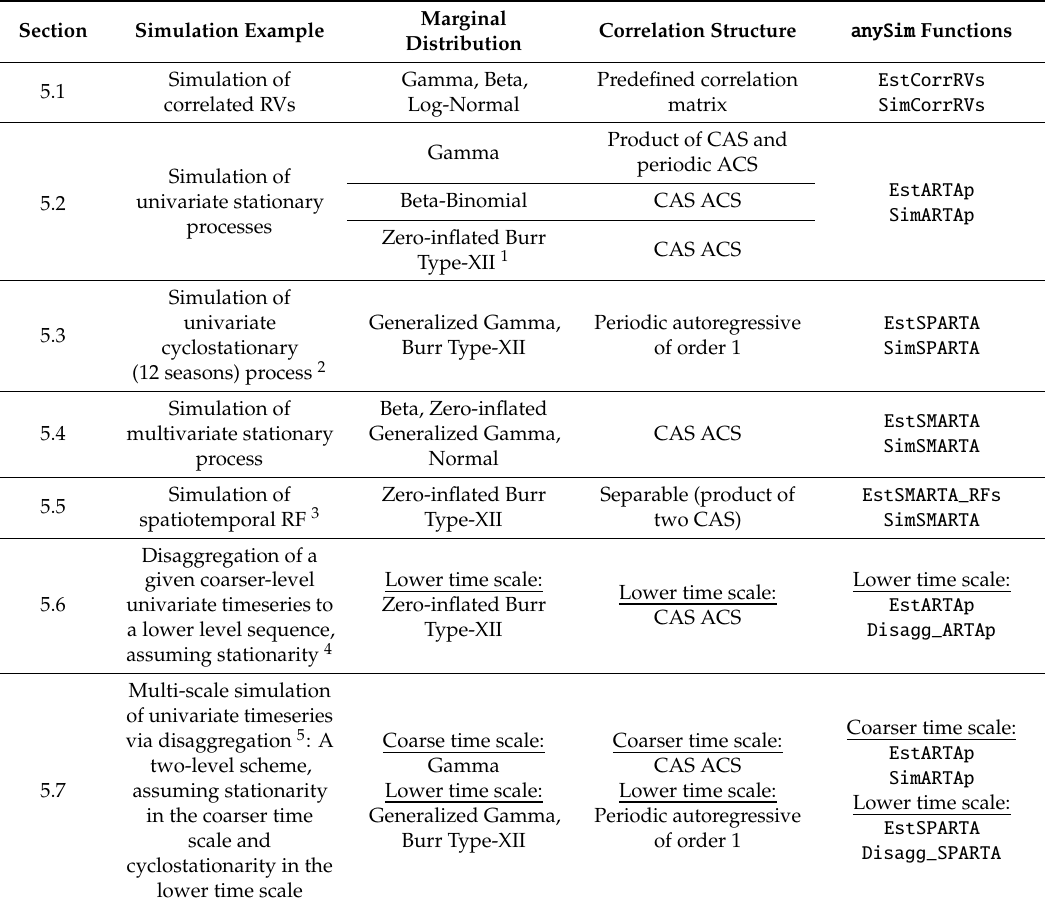
Table 1. Summary table of anySim simulation examples presented in the